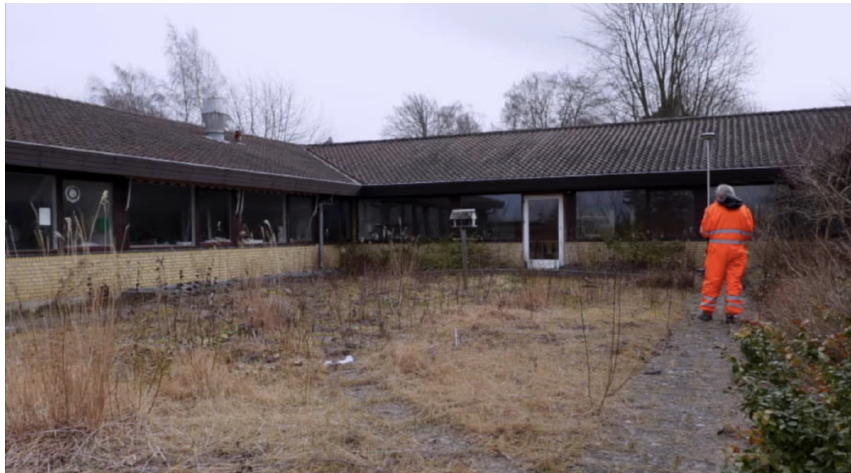
Figure 6. A surveyor measures the plot to prepare for the new construction project. March 2017. that is after all good in itself. Many people move here to be able to be oneself. Therefore, we don’t have any need to interfere too